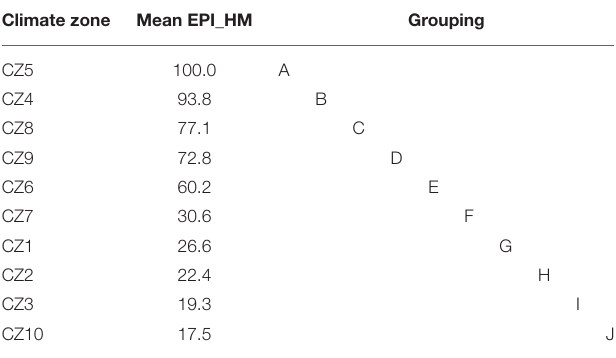
TABLE 3 | Grouping information using the Tukey method and 95% confidence.